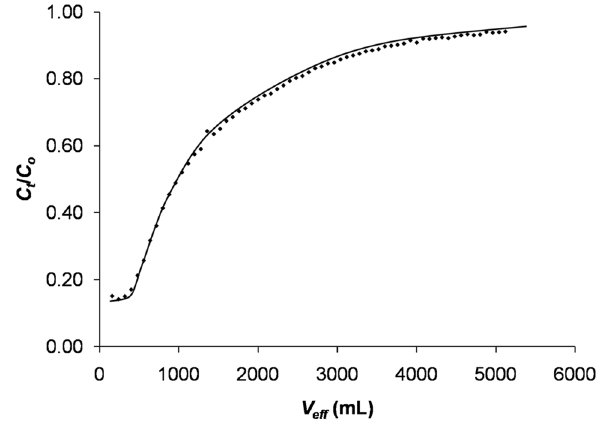
Fig. 7 Breakthrough curve of C with peel of Artocarpus nobilis fruit [Ni(II) concentration 10.0 mg L −1 , flow rate 16.0 mL min −1 , biosorbent mass 3.000 g, column height 10.0 cm, internal diameter of column 1.0 cm, sampling fre- quency 5